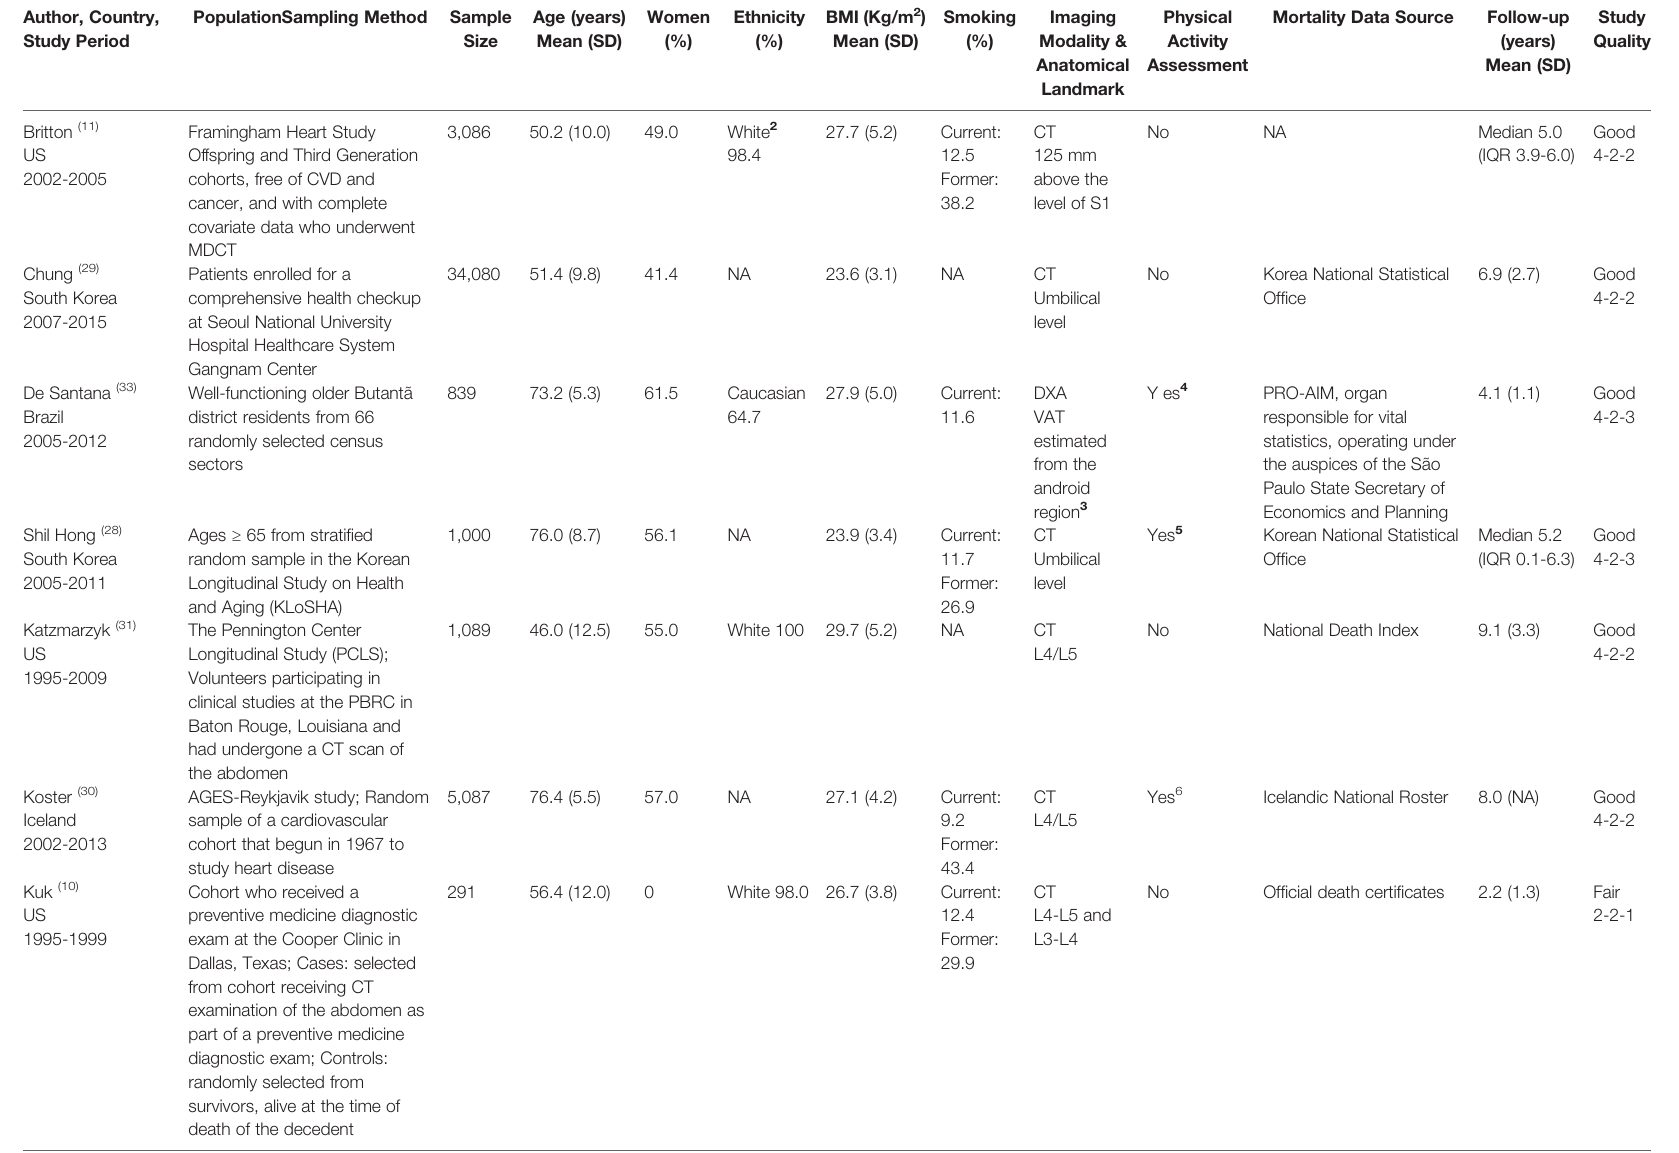
TABLE 1 | Summary of the characteristics of the included studies reporting on the association of visceral adipose tissue and all-cause mortality 1 . Author, Country, Study Period